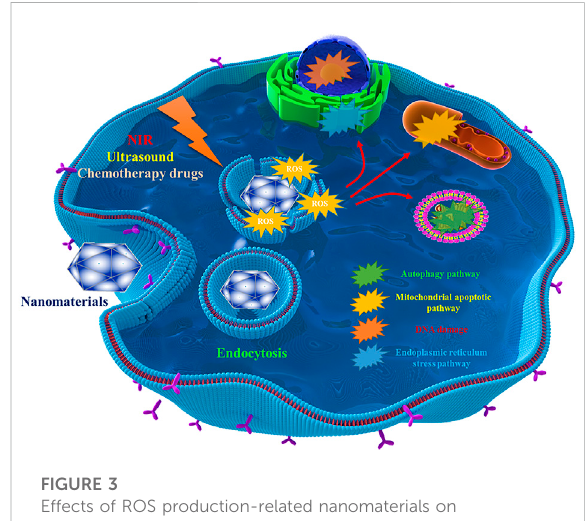
FIGURE 3 Effects of ROS production-related nanomaterials on intracellular